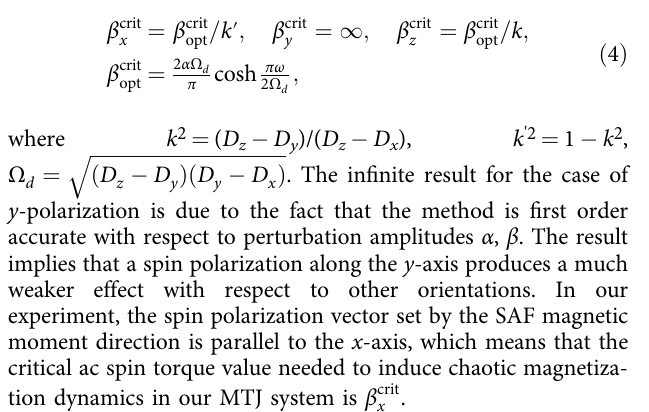
Fig. 3 Qualitative sketches of the magnetization trajectories in the ( ϕ , m z )-plane. ( ϕ is the azimuthal angle around the z -axis). a Conservative trajectories ( α = 0, β ac = 0, designated by superscript (0)). Γ 1 , Γ 2 are constant energy trajectories and Γ is the heteroclinic trajectory (separatrix). b Damping dominated dynamics ( α > 0 ; β < β crit x , d > 0). Here x d 1 , x d 2 are saddle equilibria; x s 1 , x s 2 are node-type equilibria; W s 1 is stable manifold associated with x d 1 ; W u 2 ac is unstable manifold associated with x d 2 ; d is the splitting of the manifolds. c Heteroclinic tangle formation α > 0 ; β x x x a , b , c are generated by iterating the stroboscopic map, Eq. (3). Intersecting stable and unstable manifolds form lobes. Blue regions indicate capturing lobes that keep the magnetization inside the given potential well while red regions show escaping lobes that bring magnetization outside of the well. The colored arrows indicate the transformation of one lobe into another under the action of the map,